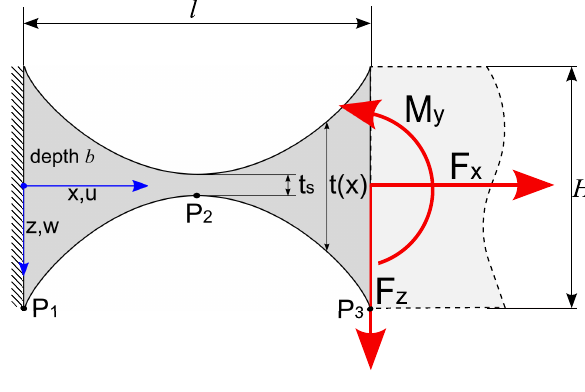
Fig. 2. Planar, flexure hinge characterized by length l , depth b , Figure 2. Planar, flexure hinge characterized by length l , depth b , height H , variable thickness t ( x ) t s and common points P 1 , P 2 , height H , variable thickness t ( x ) ≥ t s and common points P 1 , P 2 , P 3 ≥ P 3 to resist external (nodal) loads F x , F z , M y . to resist external (nodal) loads F x , F z , M y